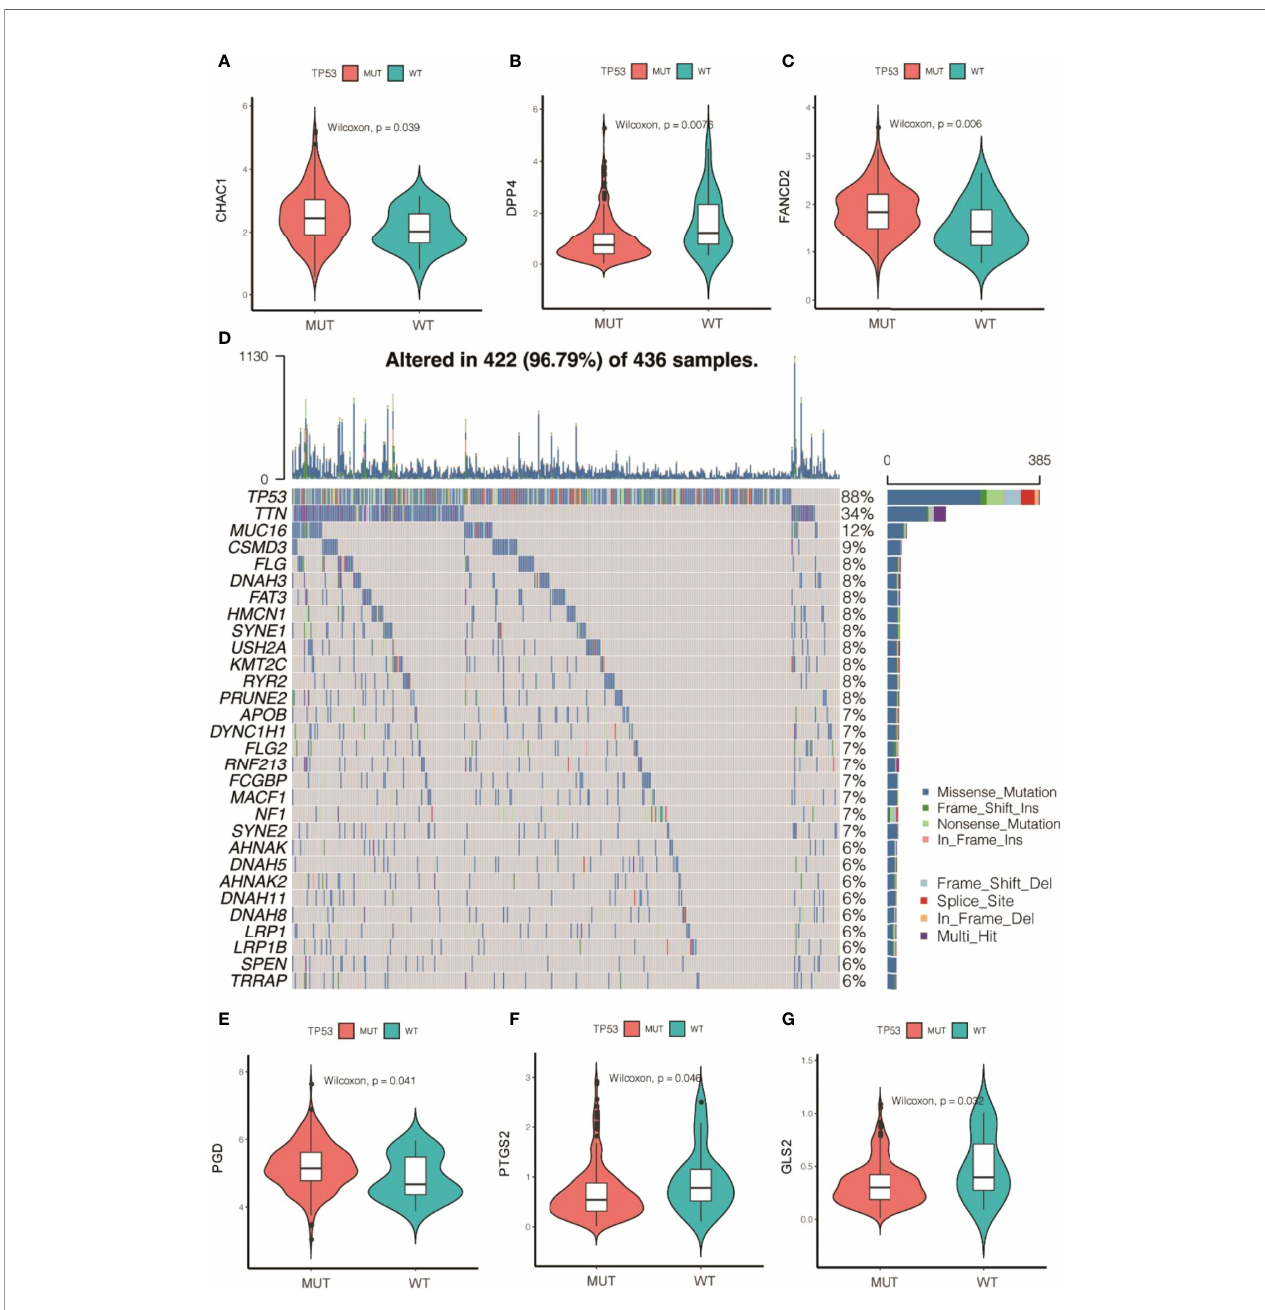
FIGURE 3 | Gene mutations of tumor samples in OC gene dataset of the Cancer Genome Atlas and its regulation on 60 ferroptosis-related genes. (A) Waterfall chart of genetic mutations; (A – G) effects of TP53 mutations on the expression of ferroptosis-related